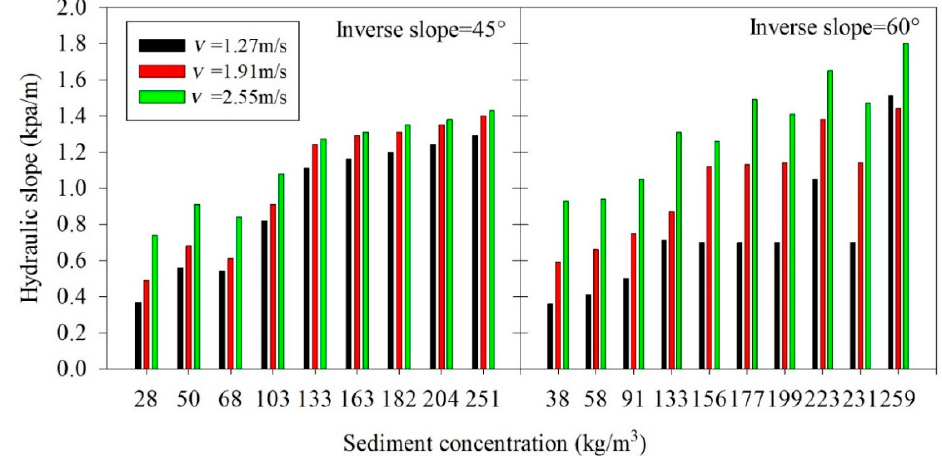
Figure 7. The hydraulic gradient of different flow rate varies with sediment concentration.